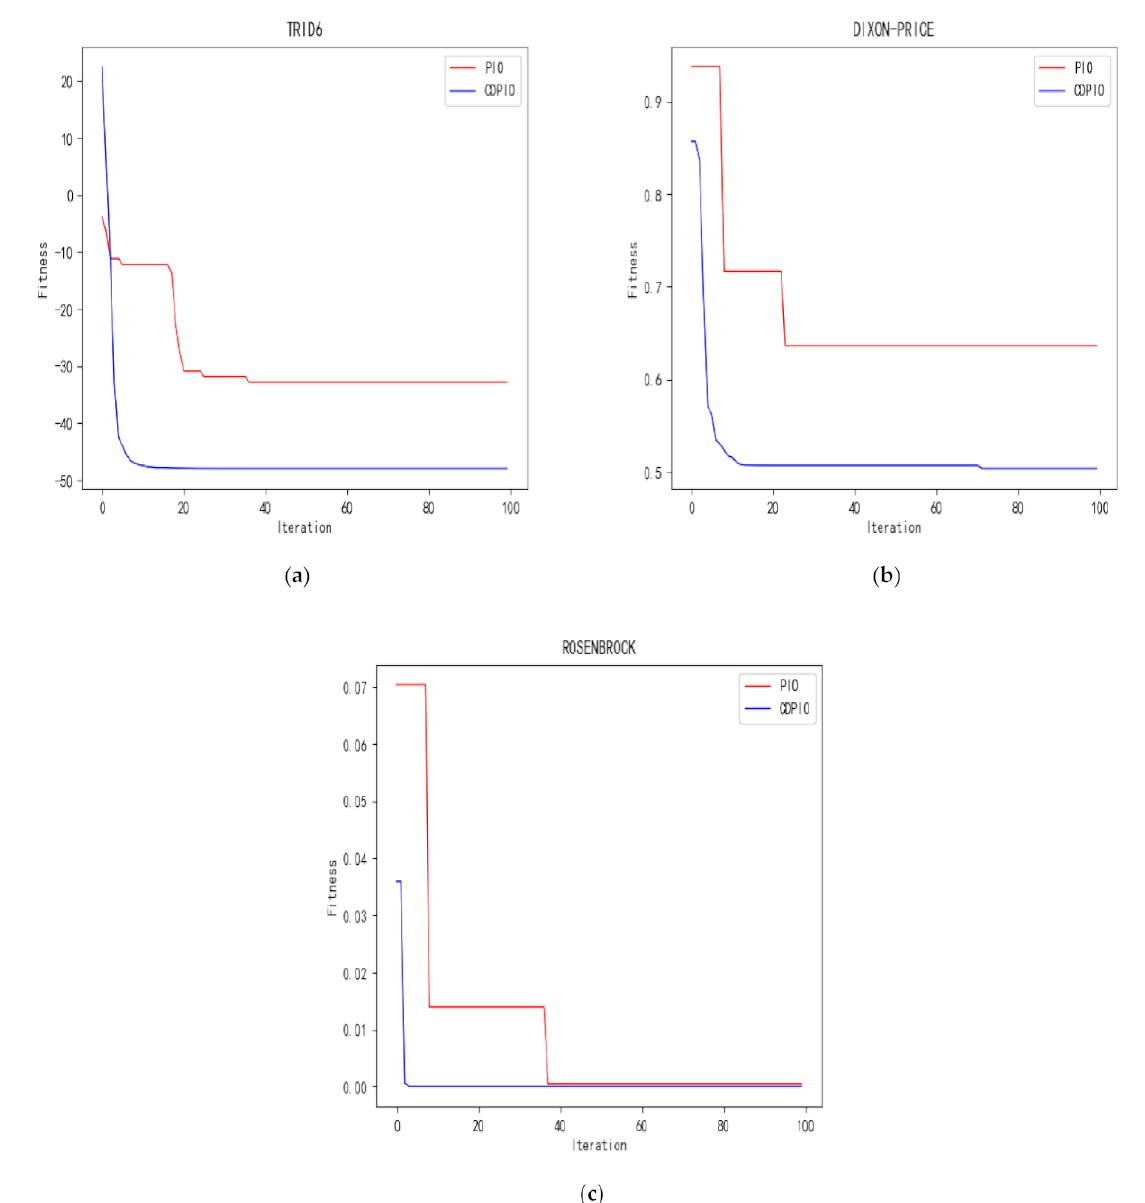
Figure 2. Comparison of convergence curves of 2 algorithms obtained on the three test functions. ( a ) is the convergence curves of 2 algorithms obtained on TRID function; ( b ) is the convergence curves of 2 algorithms obtained on DIXON-PRICE function; ( c ) is the convergence curves of 2 algorithms obtained on ROSENBROCK